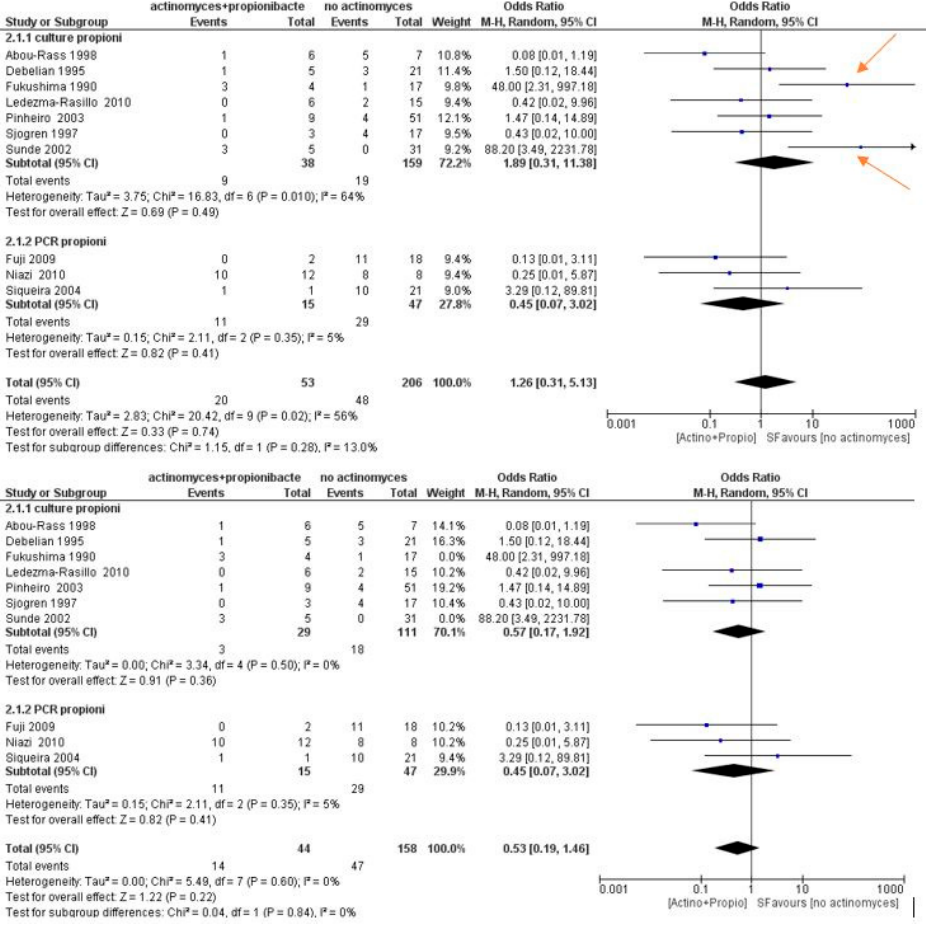
Figure 8. Forest plot of the random effects model of the meta-analysis of the sub-group Propionibacterium; the arrows indicate the sources of heterogeneity that are identified by the funnel plot and are also evident on the forest plot. Sub-group culture (OR = 1.89, 95% CI: [0.31, 11.38]), sub-group PCR (OR = 0.45, 95% CI: [0.07, 3.02]).